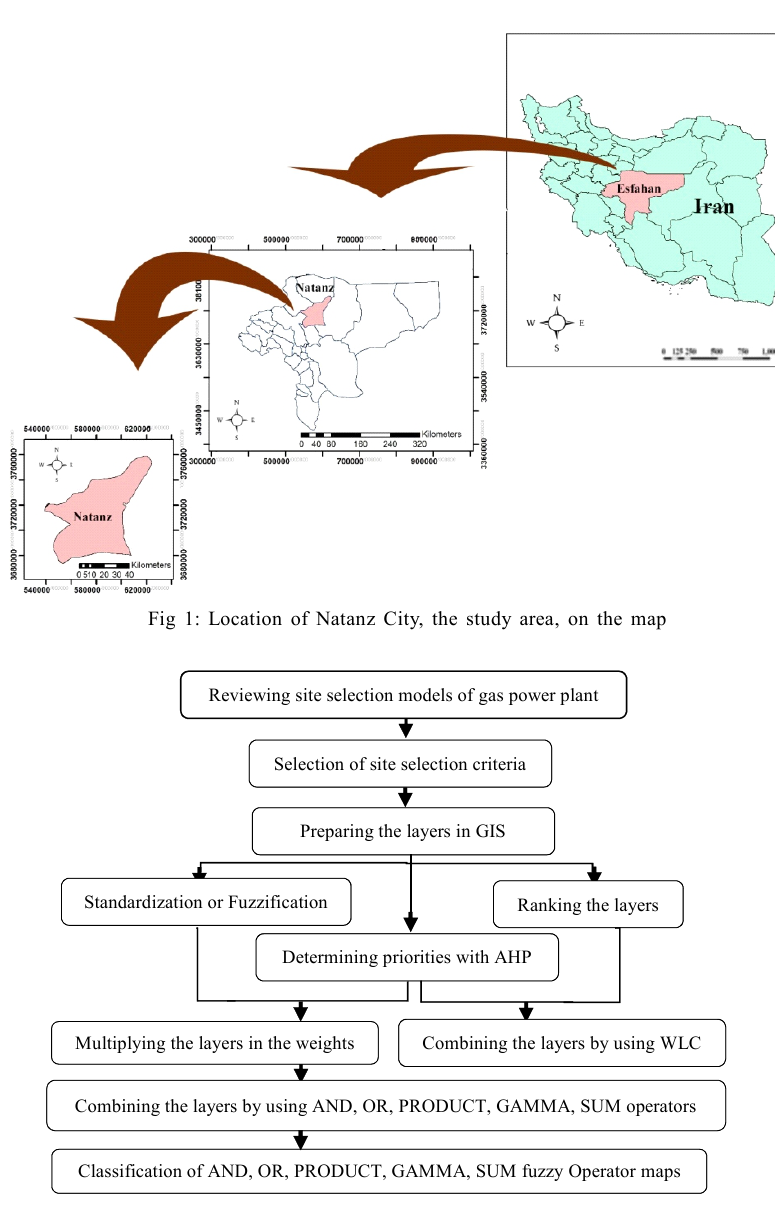
Fig 2: The flowchart of the study